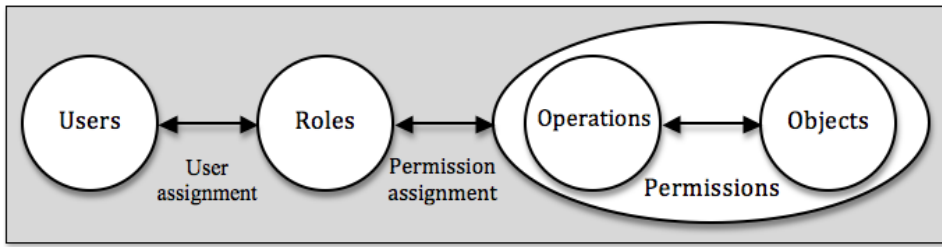
Figure 1. The core RBAC model (adapted from [14] and